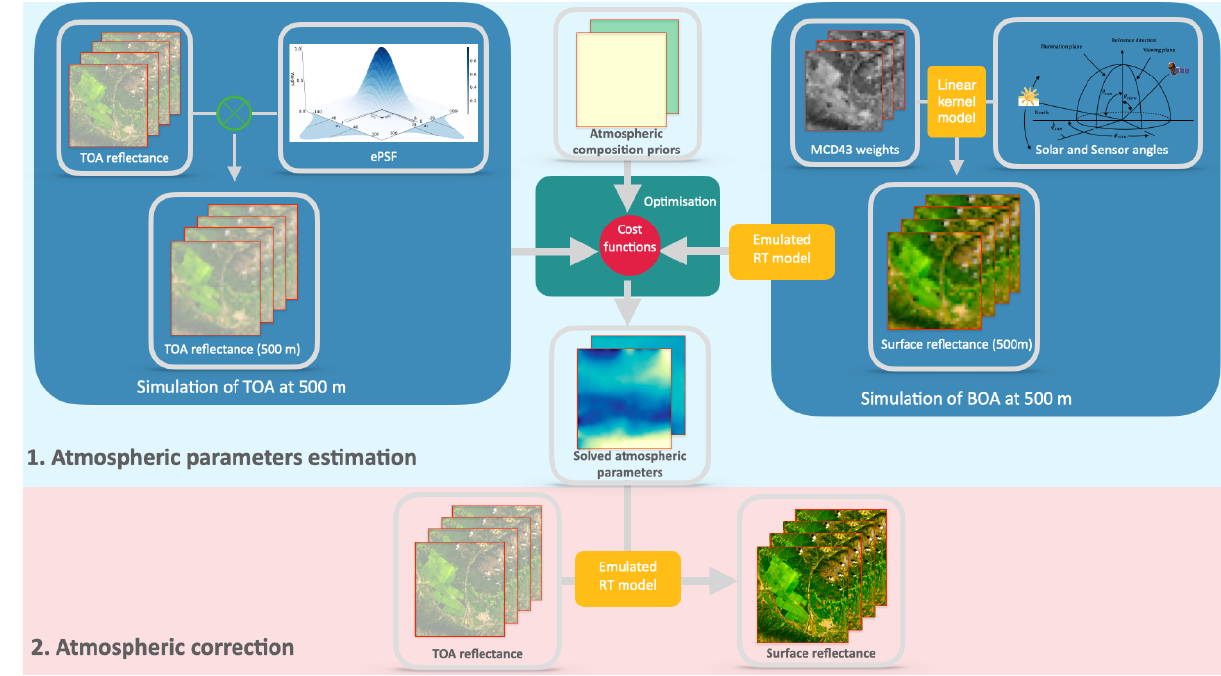
Figure 1. Schematic diagram of the SIAC processing